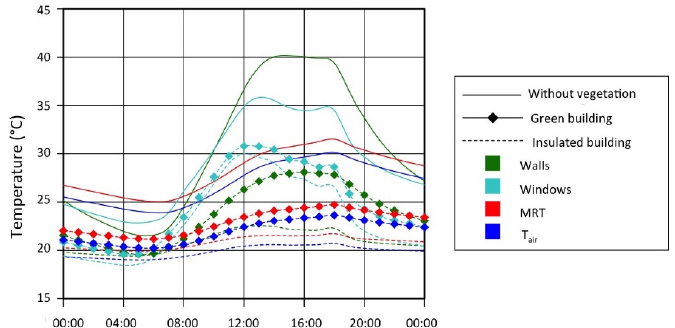
Figure 11. Internal surface temperature of windows and walls, mean radiant temperature (MRT) and indoor air temperature ( T air ) of the third floor on 26 June 2010.